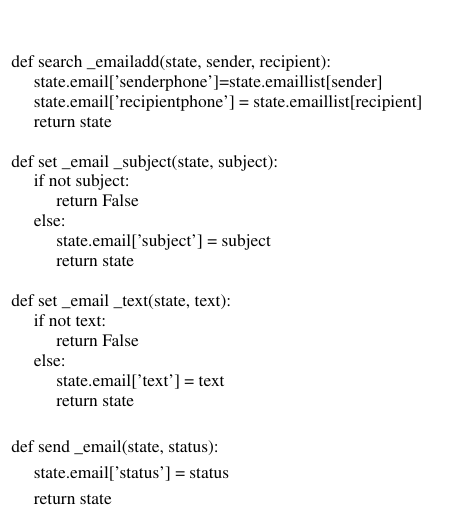
Figure 2: Plan generated by the Planning framework for communicating with the user’s